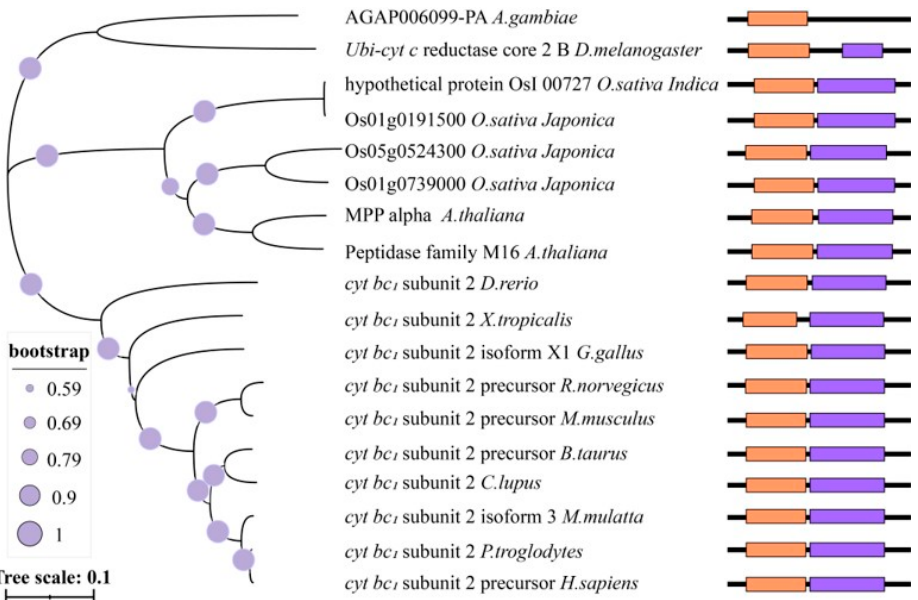
Figure 5. MPPA is conserved in the eukaryote. The full-length amino acid of MPPA and its 17 homologs were aligned by Cluster X, then the phylogenetic tree was constructed based on the neighbor-joining method with MEGA v.7.0. The p-distance model was applied with a bootstrap of 1000 replicates and the corresponding support values for each node was labeled. The right panel showed the conserved domain of MPPA and its homologs, orange rectangles indicate the M16 domain and the purple ones represent the M16C domain.